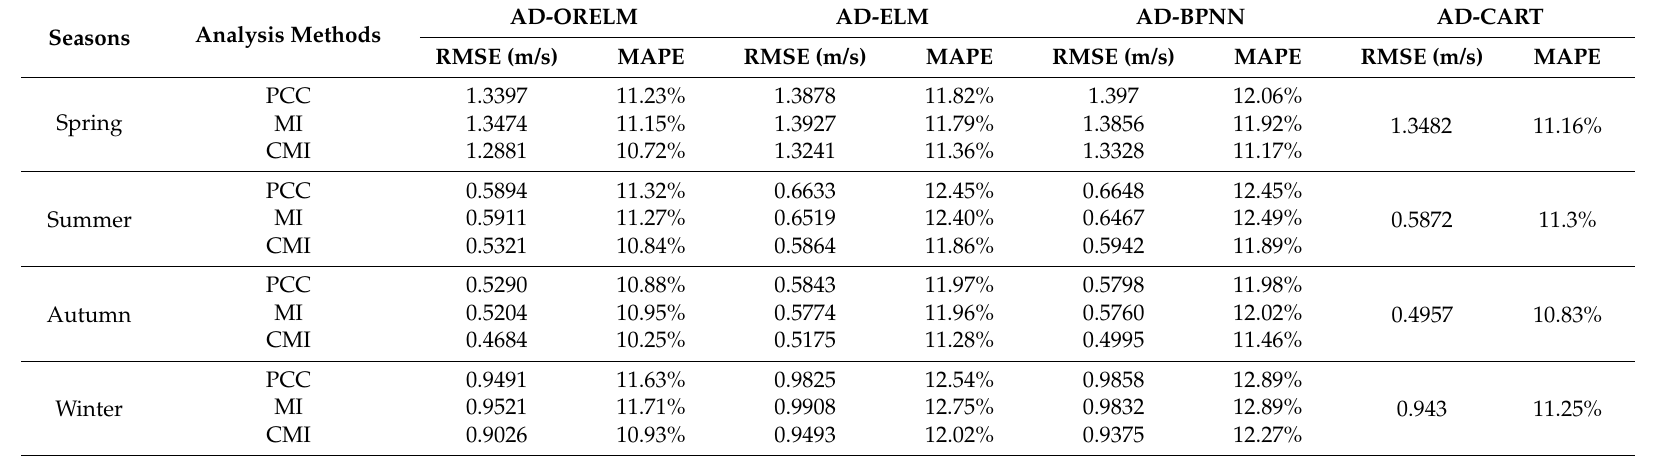
Table 9. Prediction results on all selected predict